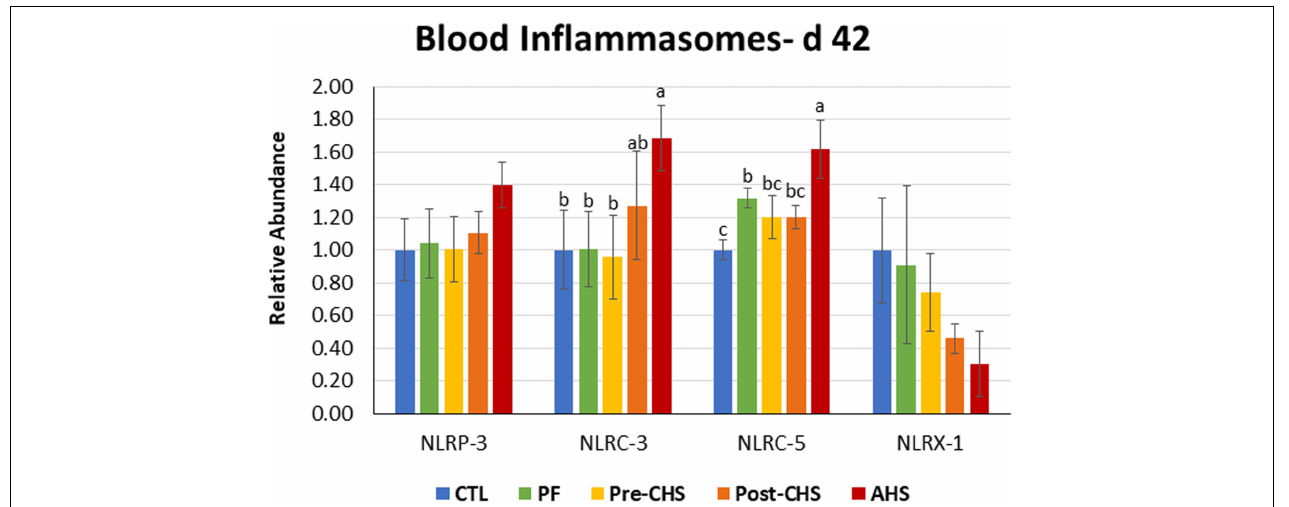
FIGURE 8 | Relative mRNA abundance of nucleotide-binding, leucine-rich repeat and pyrin domain containing ( NLRP )- 3 , nucleotide-binding oligomerization domain, leucine-rich repeat, and CARD domain containing ( NLRC )- 3 , NLRC5 , and nucleotide-binding, leucine-rich repeat containing X1 (NLRX1) in the blood of Cobb 500 male broiler chickens on day 42. Birds in all the groups were raised under the recommended conditions from day 0 to 28. Treatments include: (1) control (CTL): birds raised under thermoneutral condition (23 ◦ C) from day 29 to 42; (2) AHS: birds raised under thermoneutral condition (23 ◦ C) from day 29 to 42, but exposed to 2 h AHS (35 ◦ C) before sampling on day 42; (3) Pre-CHS: birds exposed to high ambient temperature (35 ◦ C) for 8 h/day (9:30 am–5:30 pm) from day 29 to 42, and sampled before starting the CHS; (4) Post-CHS: birds exposed to high ambient temperature (35 ◦ C) for 8 h/day (9:30 am–5:30 pm) from day 29 to 42, and sampled 2 h after starting the CHS; (5) pair-fed (PF): birds raised under thermoneutral condition (23 ◦ C) from day 29 to 42, but pair-fed to CHS group (these birds received each day 1.05 times the average feed intake recorded in the CHS group in the previous day). Values are represented as a n -fold difference relative to the calibrator (CTL). Results are given as means ( n = 8) for each group. Error bars indicate standard errors. For each gene, bars with different letters are significantly different ( P <